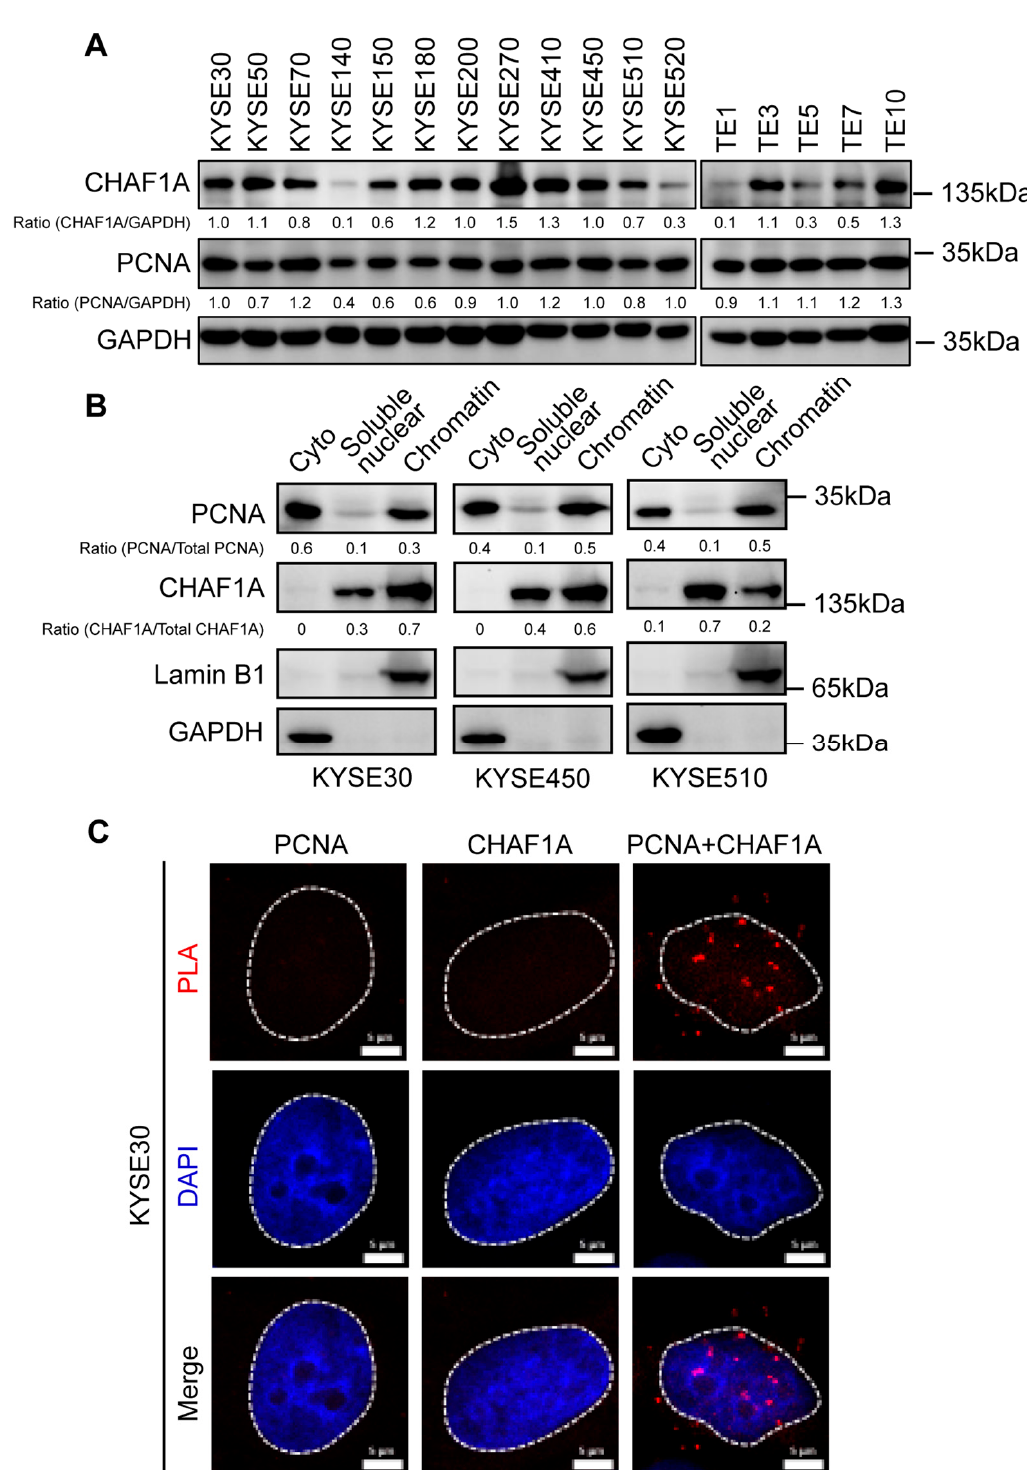
Figure 2. Expression, localization, and interaction of CHAF1A and PCNA in EC cells. ( A ) CHAF1A and PCNA expression in 17 EC cell lines detected by western blotting. ( B ) Cytoplasmic (Cyto), soluble nuclear, and chromatin distribution of PCNA and CHAF1A in KYSE30, KYSE450, and KYSE510 cells subjected to cell fractionation assays and western blotting. Lamin B1 was used as a chromatin marker, and GAPDH was used as a cytoplasmic marker. ( C ) Co-localization of PCNA-CHAF1A was determined using a PLA probe in KYSE30 cells. Scale bars, 5 µm.